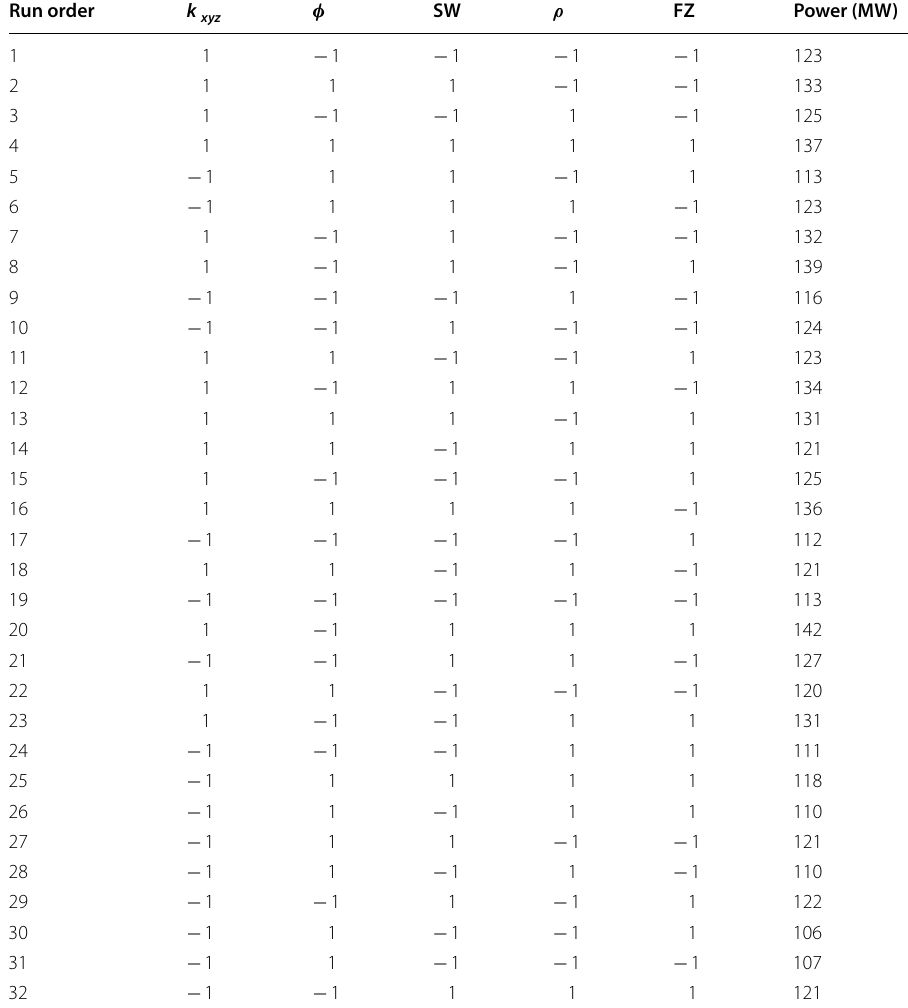
Table 5 K–TB reservoir numerical model results to full factorial design results for five parameters at two